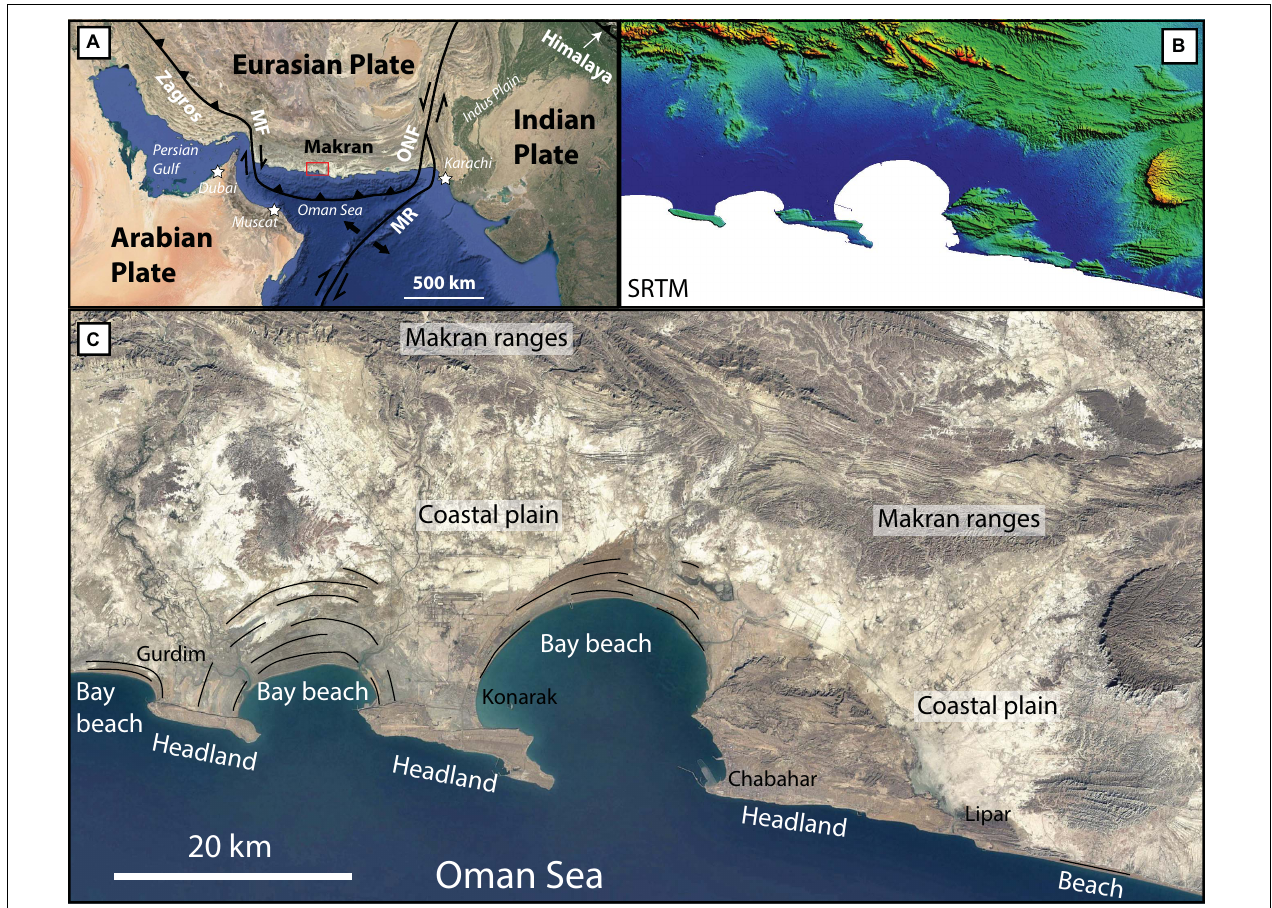
FIGURE 1 | General location of the Makran Subduction zone. (A) Tectonic setting. MF, Minab fault zone; MR, Murray Ridge; ONF, Ornach-Nal fault. (B) Shaded relief (SRTM) image of panel C (dark blue = 0 m, red = 700 m altitude). Note the flat coastal plain and the protruding headlands at the coastline. (C) Landsat satellite image of a portion of the coastal Makran near Chabahar (SE Iran). Black lines are beach ridges. Black names are localities. Headlands host marine terraces.